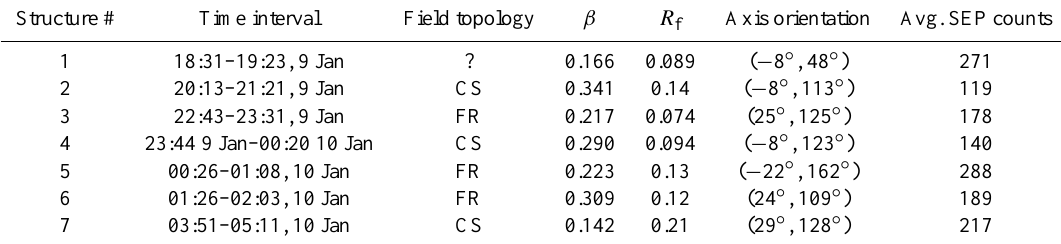
Table 1. The table reports the principal characteristics of the seven structures recovered with GS method. The start and end times, their field topology (current sheet CS), flux rope (FR) or uncertain topology (?)), their average β values and their quality factor for GS assumptions R f are reported in the first four columns. Then, it is reported the direction of the invariant axis of these structures, with the azimuthal and polar angles, and the average SEP counts measured within these